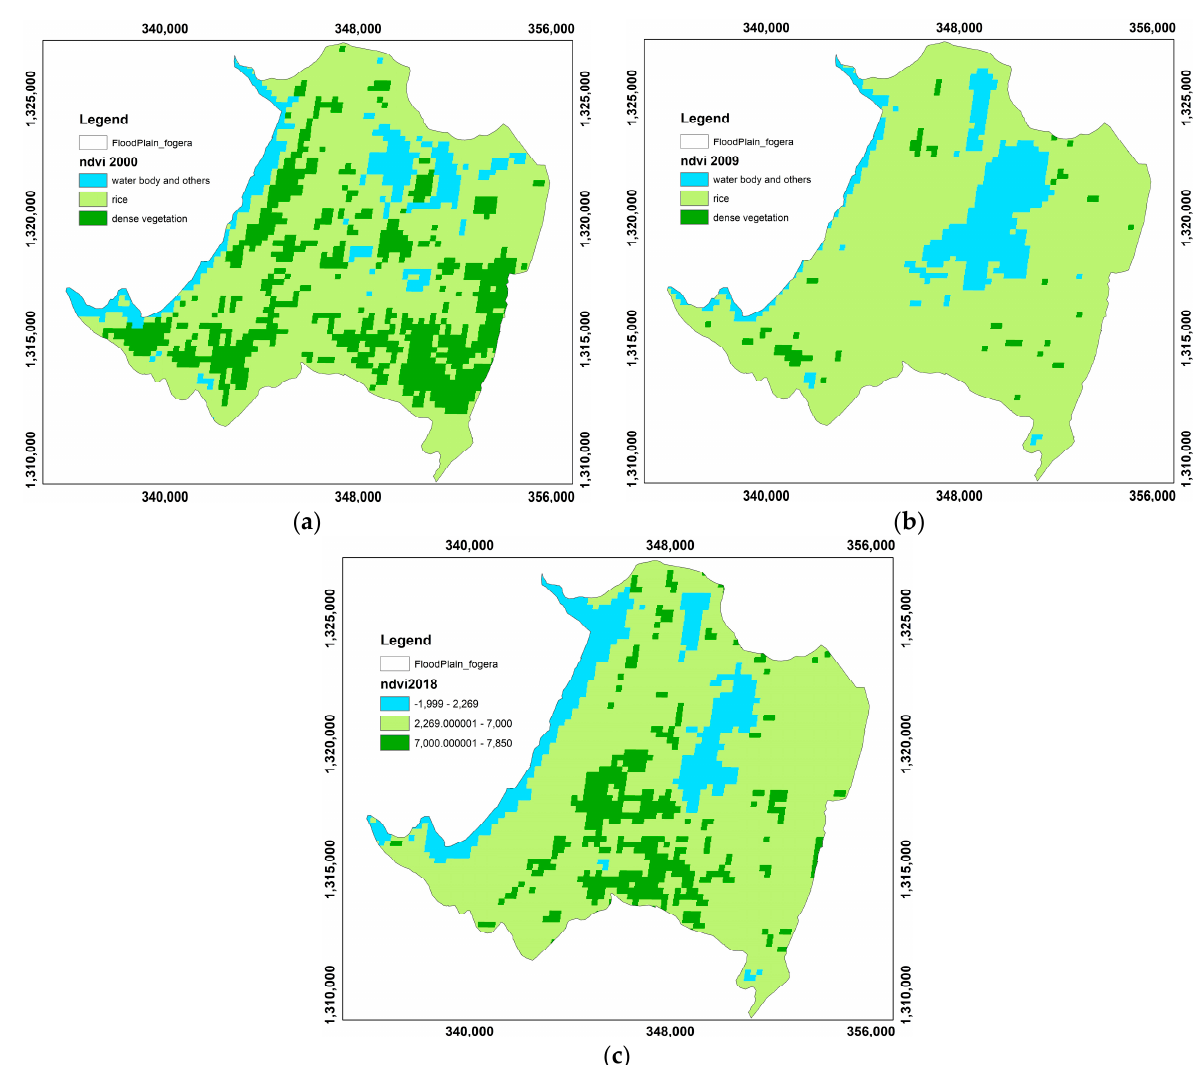
Figure 4. NDVI maps of Fogera floodplain area. ( a ) Average NDVI classes from June to September (wet season) in 2000, ( b ) average NDVI classes from June to September in 2009, and ( c ) average NDVI classes from June to September in 2018.